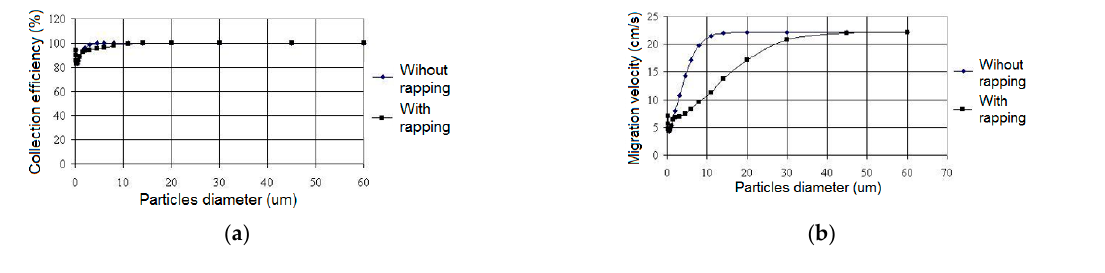
Figure 10. ( a ) The collection efficiency depends on the diameter of the dust particles. ( b ) The migration velocity depends on the diameter of the dust particles, without and with rapping, and the thickness of the 1 mm dust layer.